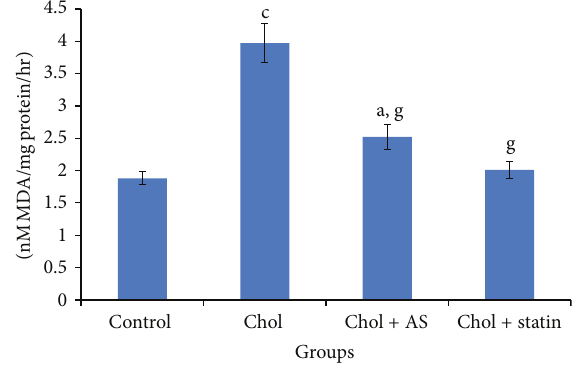
Figure 2: Effects of Acacia senegal seed extract (AS, 500 mg/kg/day, p.o.) or statin (0.25 mg/kg/day, p.o.) treatment for 45 days on athero- genic index in hypercholesterolemic (Chol) diet fed atherosclerotic male rabbits. Data are means ± S.E.M. ( 𝑛 = 8 ); a, 𝑃 ≤ 0.05 and c, 𝑃 ≤ 0.001 as compared to the respective control values and g, 𝑃 ≤ 0.001 as compared to the respective values of the Chol diet fed